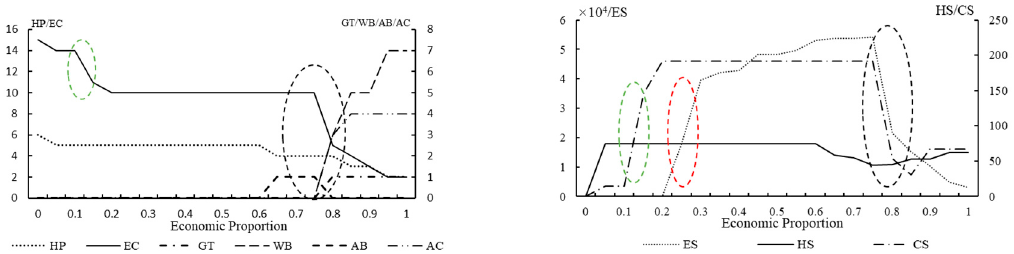
Figure 20. Device installation under different proportions.